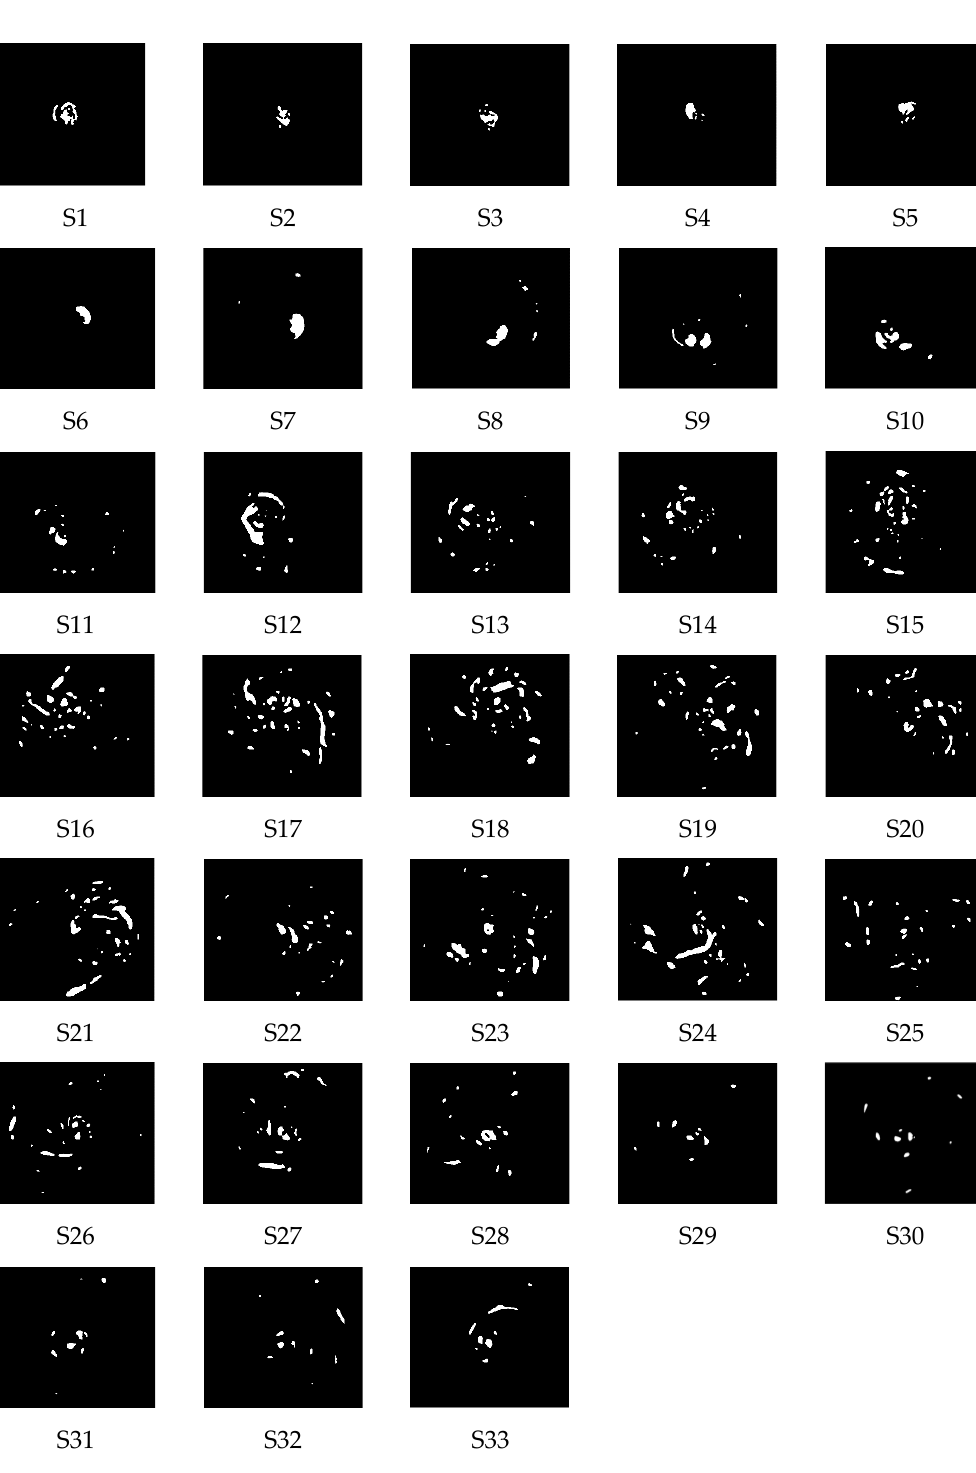
Figure 10. Vortex distribution on each section after morphological operation. The vortex rope has obvious eccentricity and precession in the process of downstream development, and with the increase of the cross-section area, the eccentricity becomes stronger and stronger until the cross-section area stops increasing and converges again into a straight vortex rope. The strength of the straight vortex rope is obviously weakened compared with that of the spiral vortex rope initially located at the runner nozzle. The flow loses energy when flowing through the expanding section. When the vortex rope is in the expanding tube, there also exists an obvious energy loss. The helical action on the